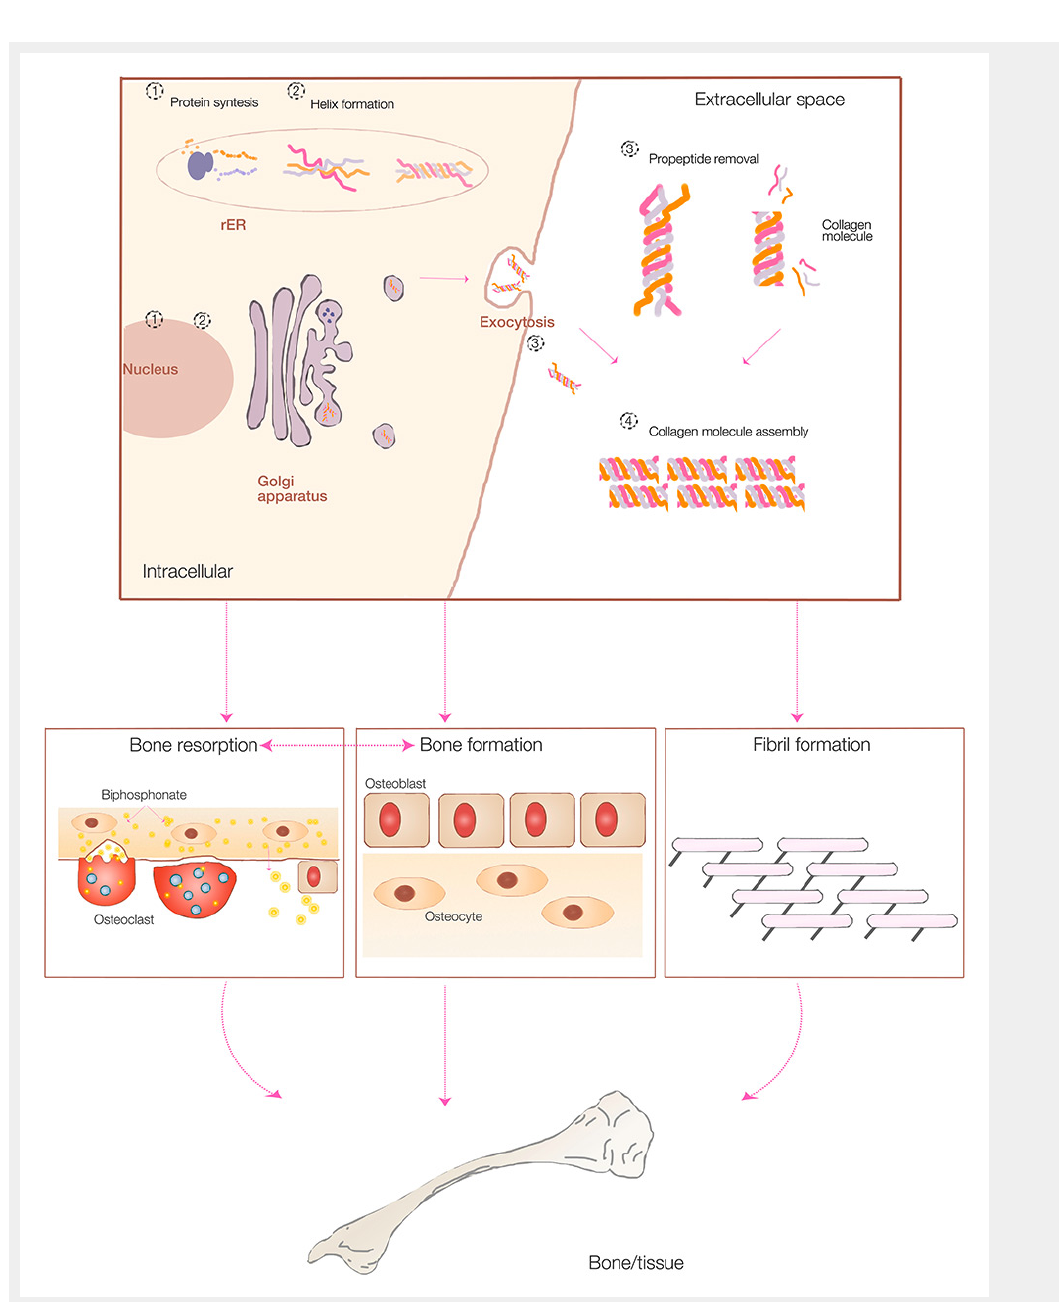
Collagen type I biosynthesis and bone formation. Collagen I is a triple helix with two alpha-1 and one alpha-2 chains encoded by COL1A1 and COL1A2 genes. After translation, the pro-alpha-chains are translocated in the rough endoplasmic reticulum (rER) where posttranslational modifications occur (1)(2). The chains are folded in a triple helix, composed of two alpha-1 and one alpha-2 chains (2). These steps are, among others, under the control of CRTAP , LEPRE 1 , PPIB and FKBP10 genes. The procollagen is then further modified during the transport to the Golgi apparatus (influence of SERPINH1 , PLOD2 and FKBP10 genes). The procollagen is then delivered into the extracellular matrix by exocytosis. There, cleavage and removal of the pro-peptides N and C results in collagen I formation (3). Crosslinking of collagen molecules leads to fibril formation. Assembly of multiple collagen type 1 fibrils leads to collagen fibres which are constituents of bone (4). Osteoblasts produce a collagen-rich extracellular matrix that will be mineralised and osteoclasts degrade bone. Bone formation and resorption is regulated through cross-talk between osteoblasts and osteoclasts. In osteogenesis imperfecta, altered quality and/or quantity of collagen I formation, altered cross-talk between osteoblasts and osteoblasts, leads to a defect in bone formation. Bisphosphonates concentrate in the mineralised osseous matrix where they inhibit bone resorption by